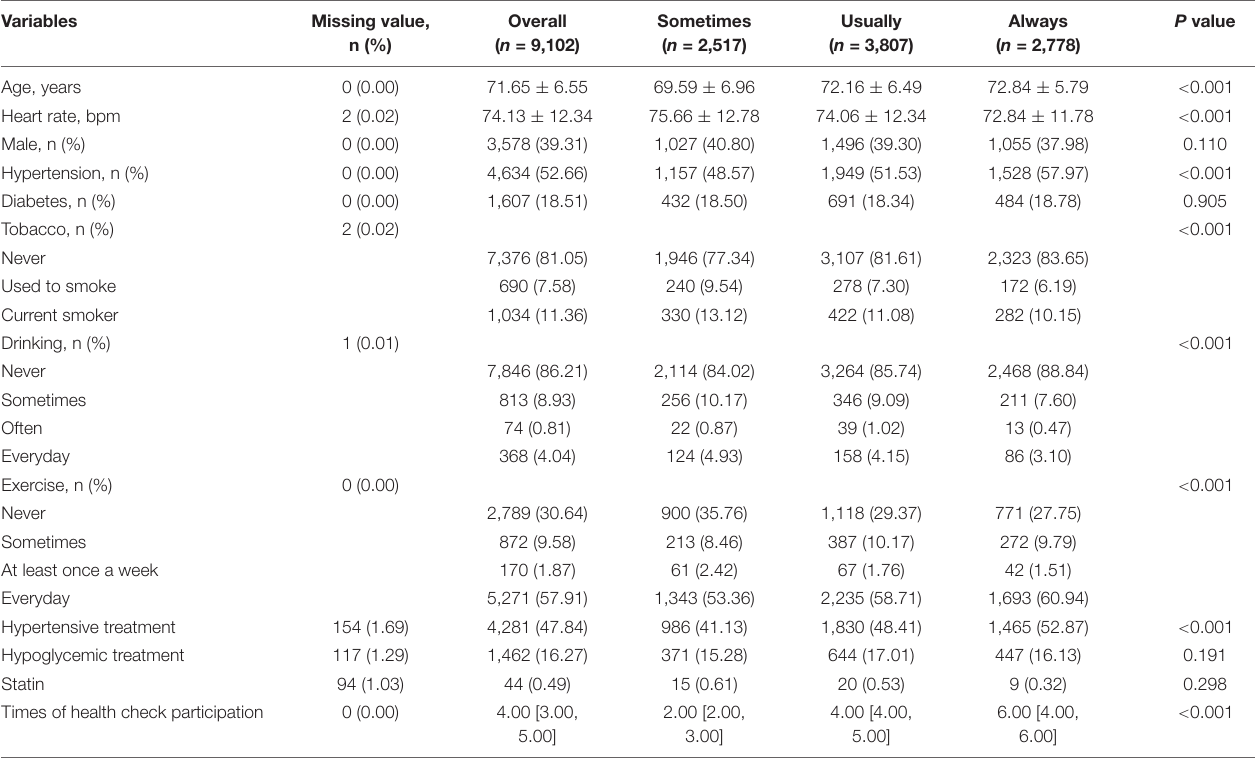
TABLE 1 | Characteristics stratified by health check frequency.